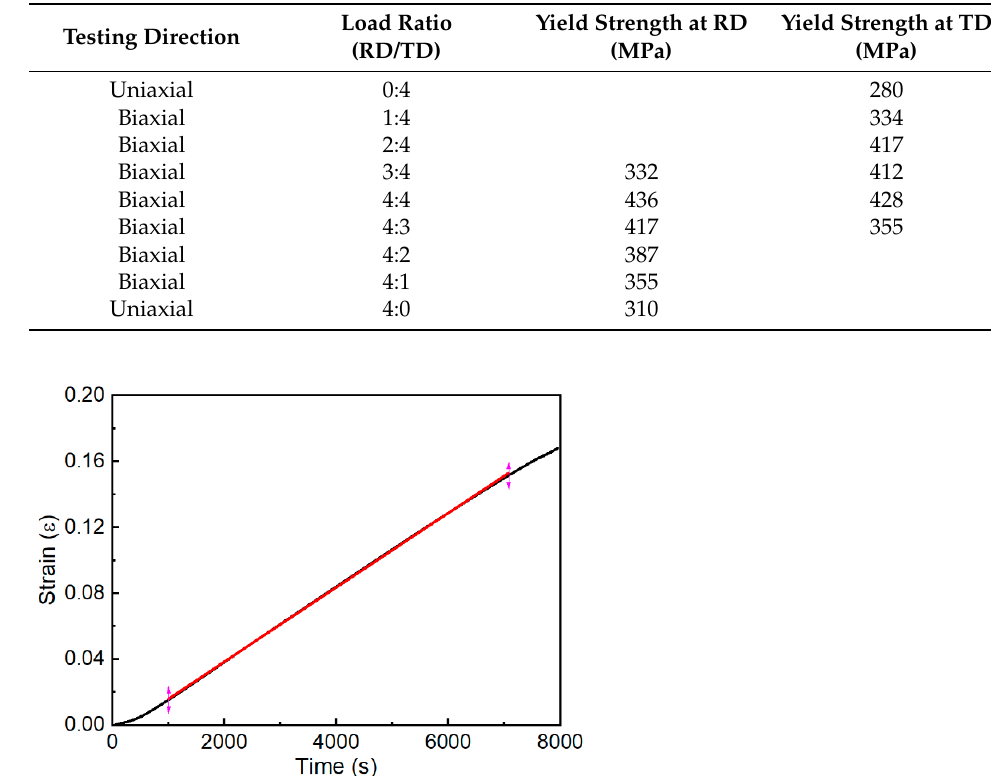
Table 1. Biaxial tensile tests data at various load ratios.